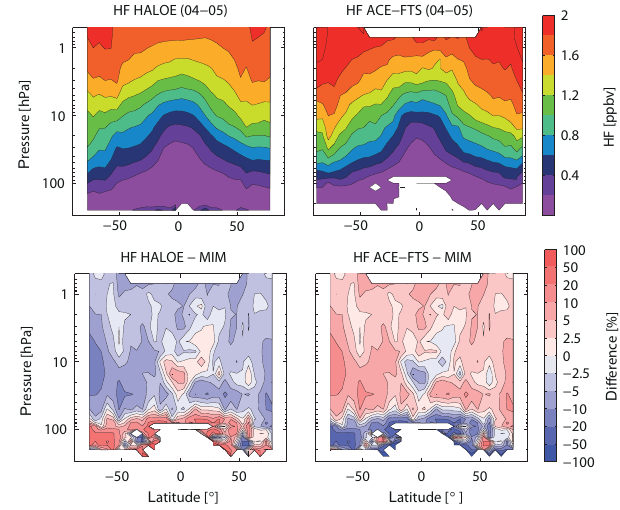
Figure 8. Altitude–latitude cross sections of annual zonal mean HF (upper panels) for HALOE and ACE-FTS and relative differences between the individual instruments and the MIM (lower panels) are shown for